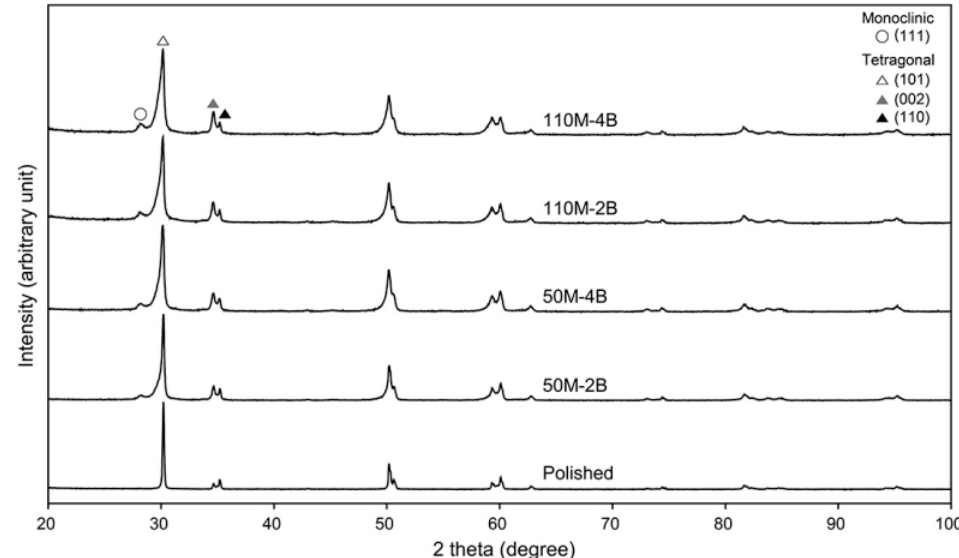
Figure 2. X-ray diffraction patterns for the polished and sandblasted zirconia surfaces.